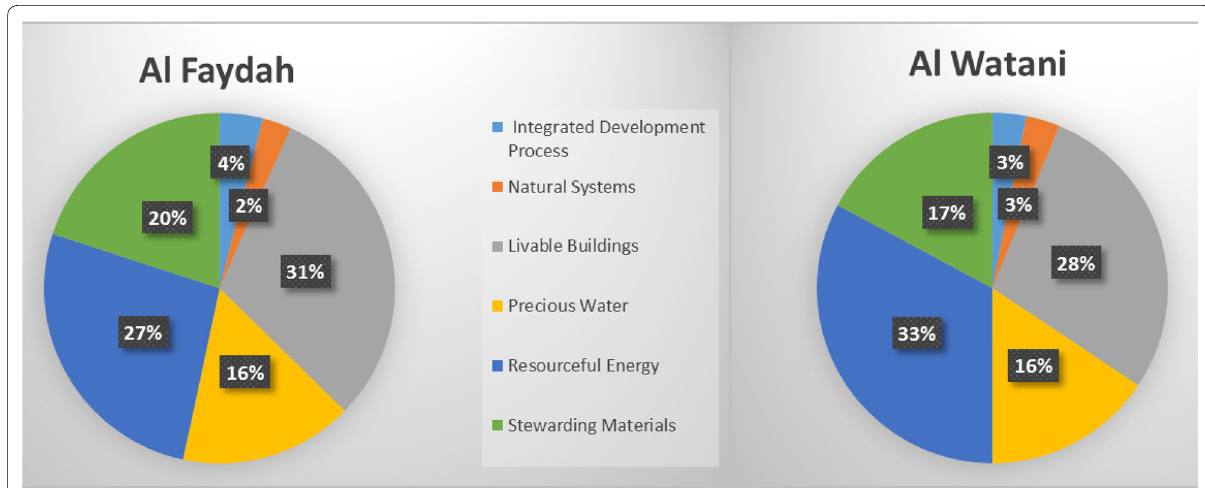
Fig. 10 The percentage ratio of credit points according to Estidama PBRS V1.0 for the studied state housing